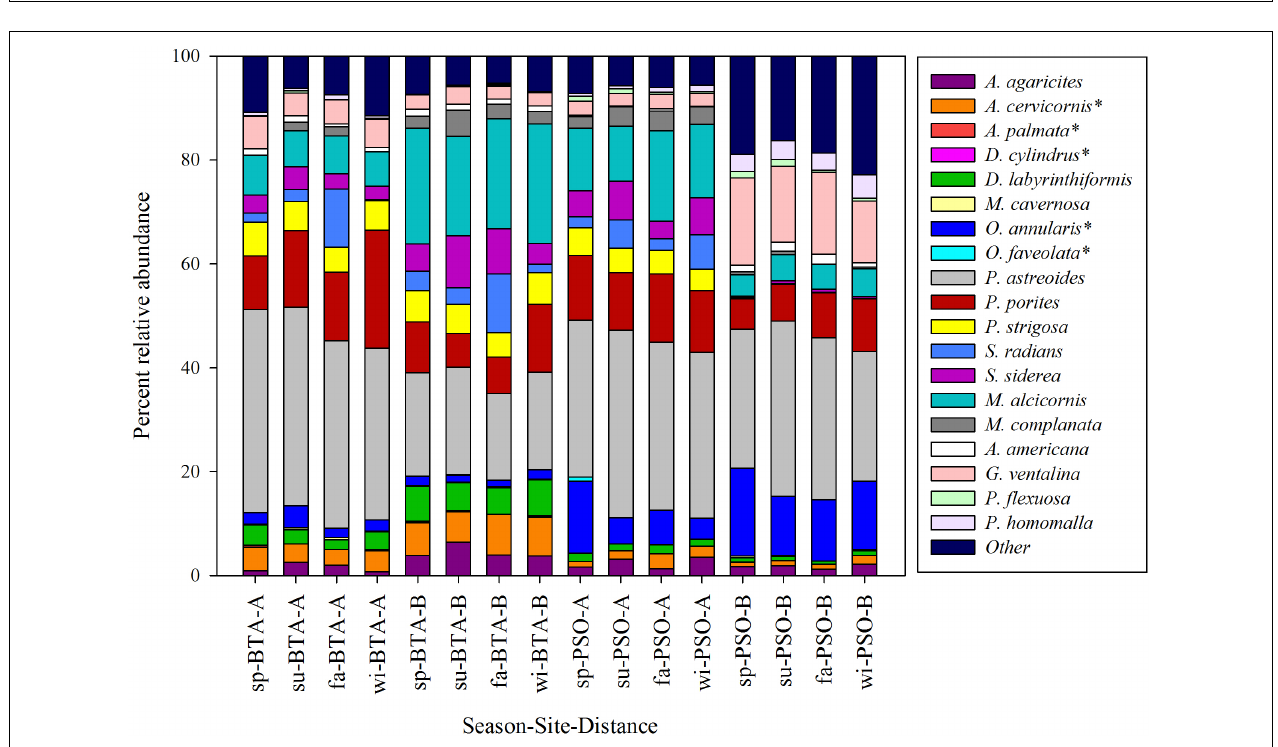
FIGURE 3 | Percent relative abundance of scleractinians, octocorals and octocoral species by season, site and distance zones. Colors represent coral species and asterisk identifies coral species listed as threatened under the Endangered Species Act (Federal Register, 2014). Seasons are defined as: sp, spring; su, summer; fa, fall; wi, winter.